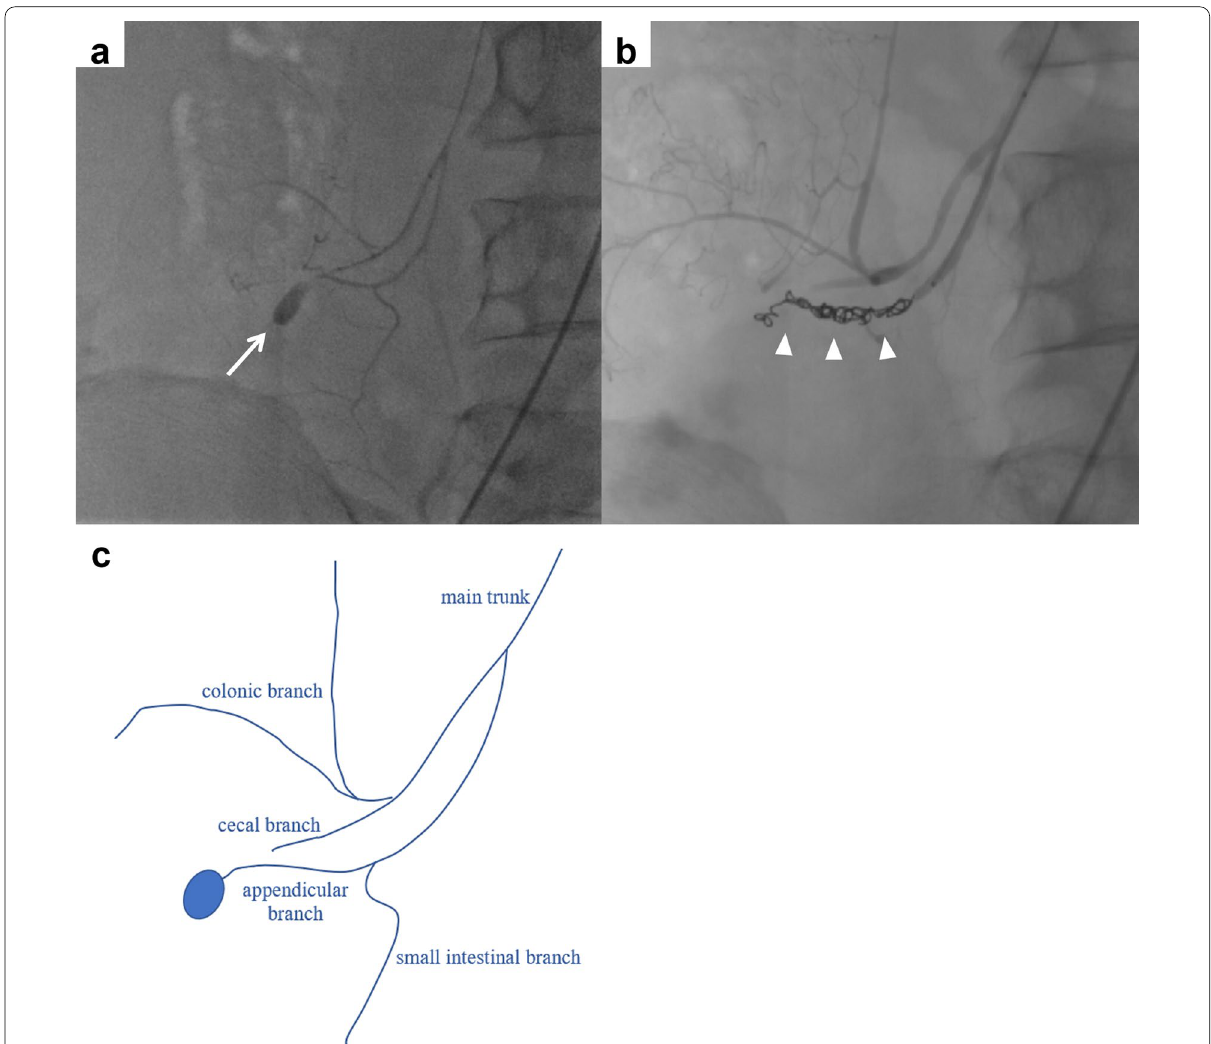
Fig. 3 Interventional radiology findings. a Pseudoaneurysm was visualized in the appendicular branch of the ileocolic artery (arrow). b Coiling was performed from the pseudoaneurysm to the origin of the appendicular branch of the ileocolic artery, after which the pseudoaneurysm disappeared (arrowhead). c Illustration of the anatomy shown by